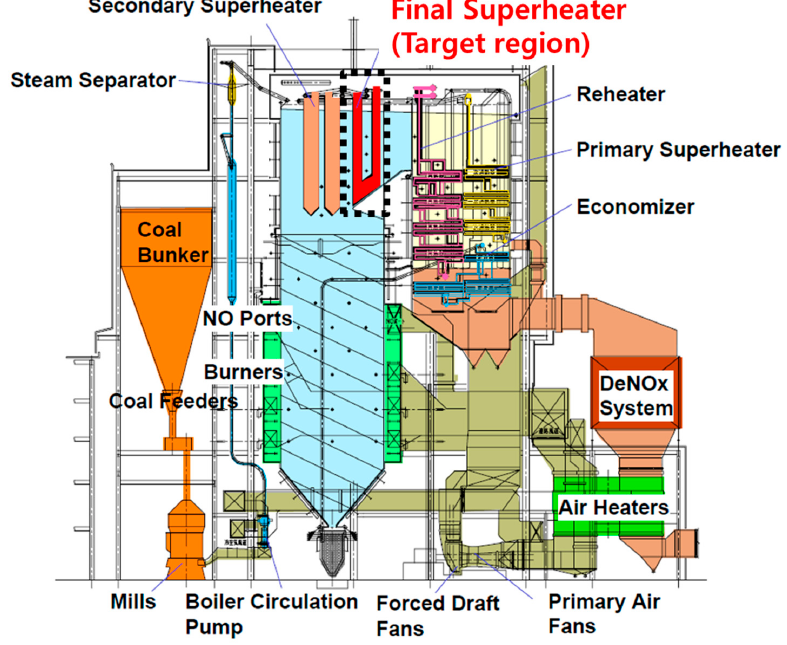
Figure 1. Schematic of ultra ‐ supercritical boiler [2].